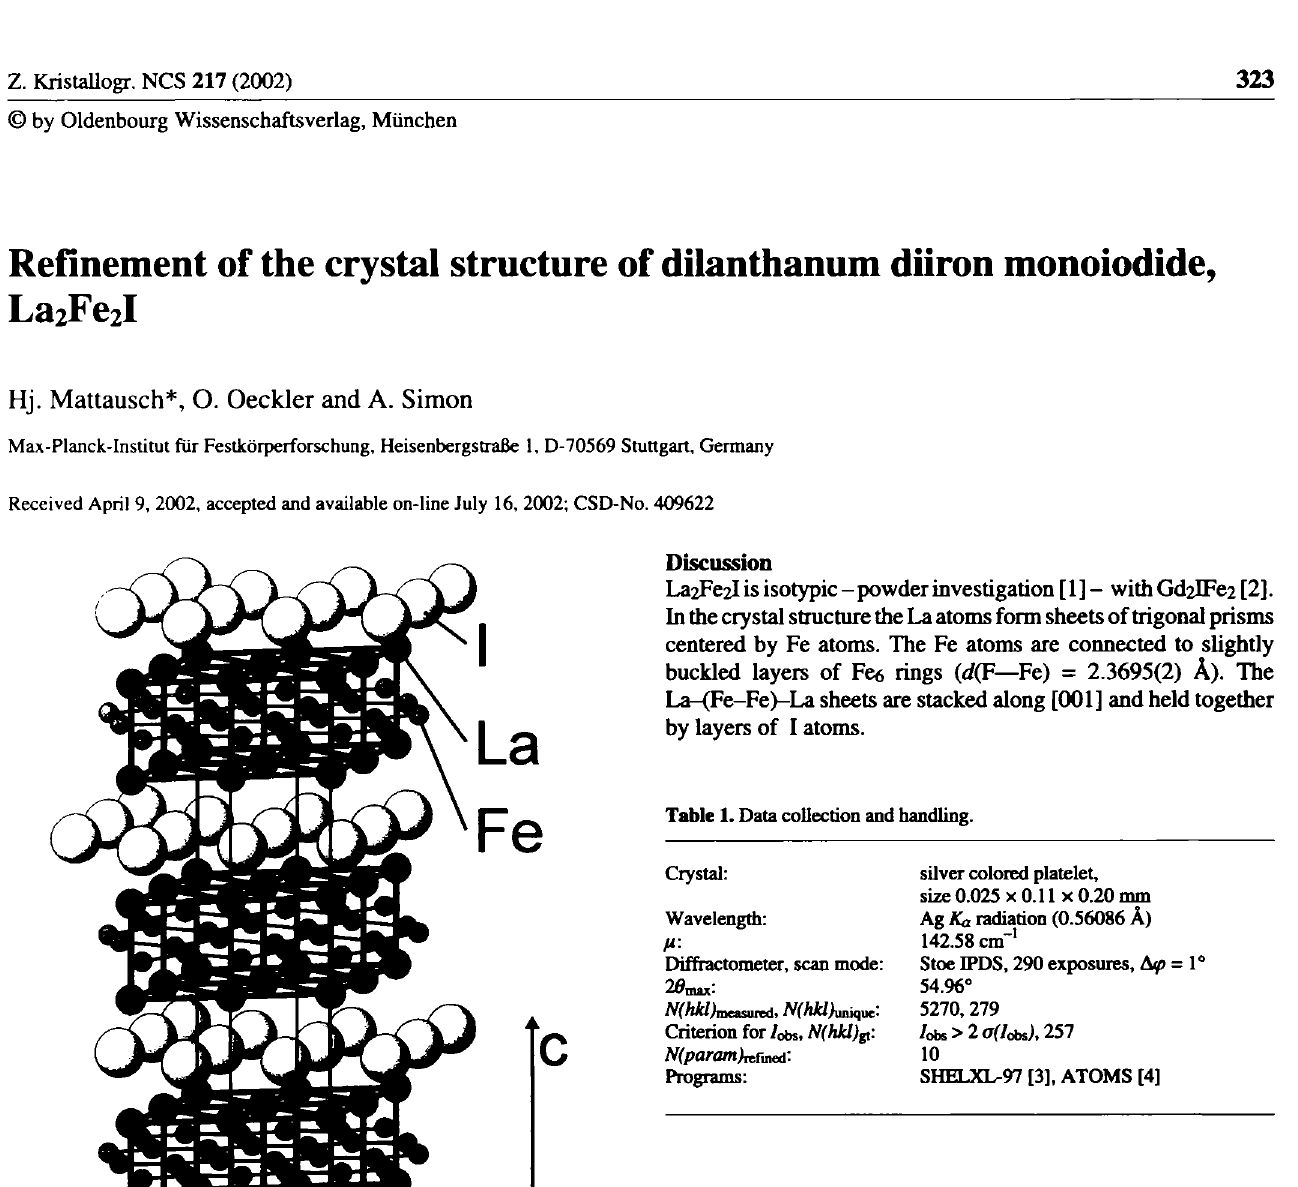
Table 1. Data collection and handling.